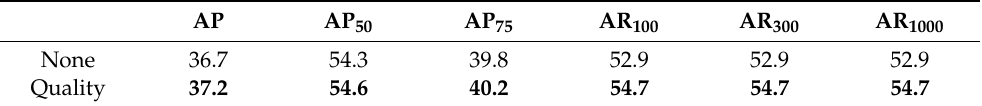
Table 2. Ablation study for quality branch on the MS COCO minival set. “None” denote that no “quality” is used. “Quality” is that using quality predicted from the quality branch. Bold font indicates the best results.